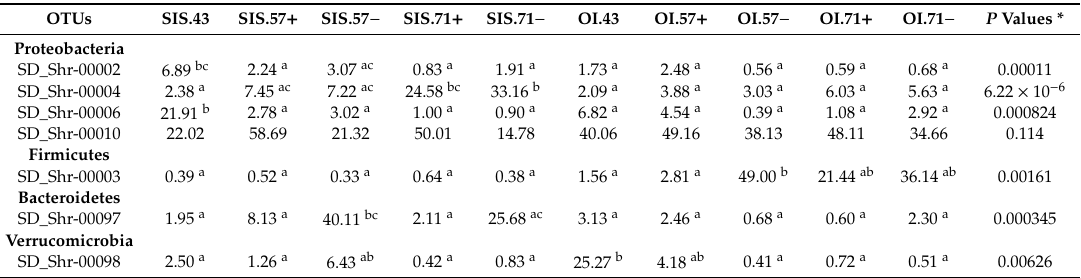
Table 3. Mean relative abundance (%) of main bacterial operational taxonomic units in the intestinal tract of whiteleg shrimp from two genetic lines (SIS or OI), in the presence ( + ) or absence ( − ) of probiotic treatment, at three di ff erent sampling time points (day 43, day 57 and day